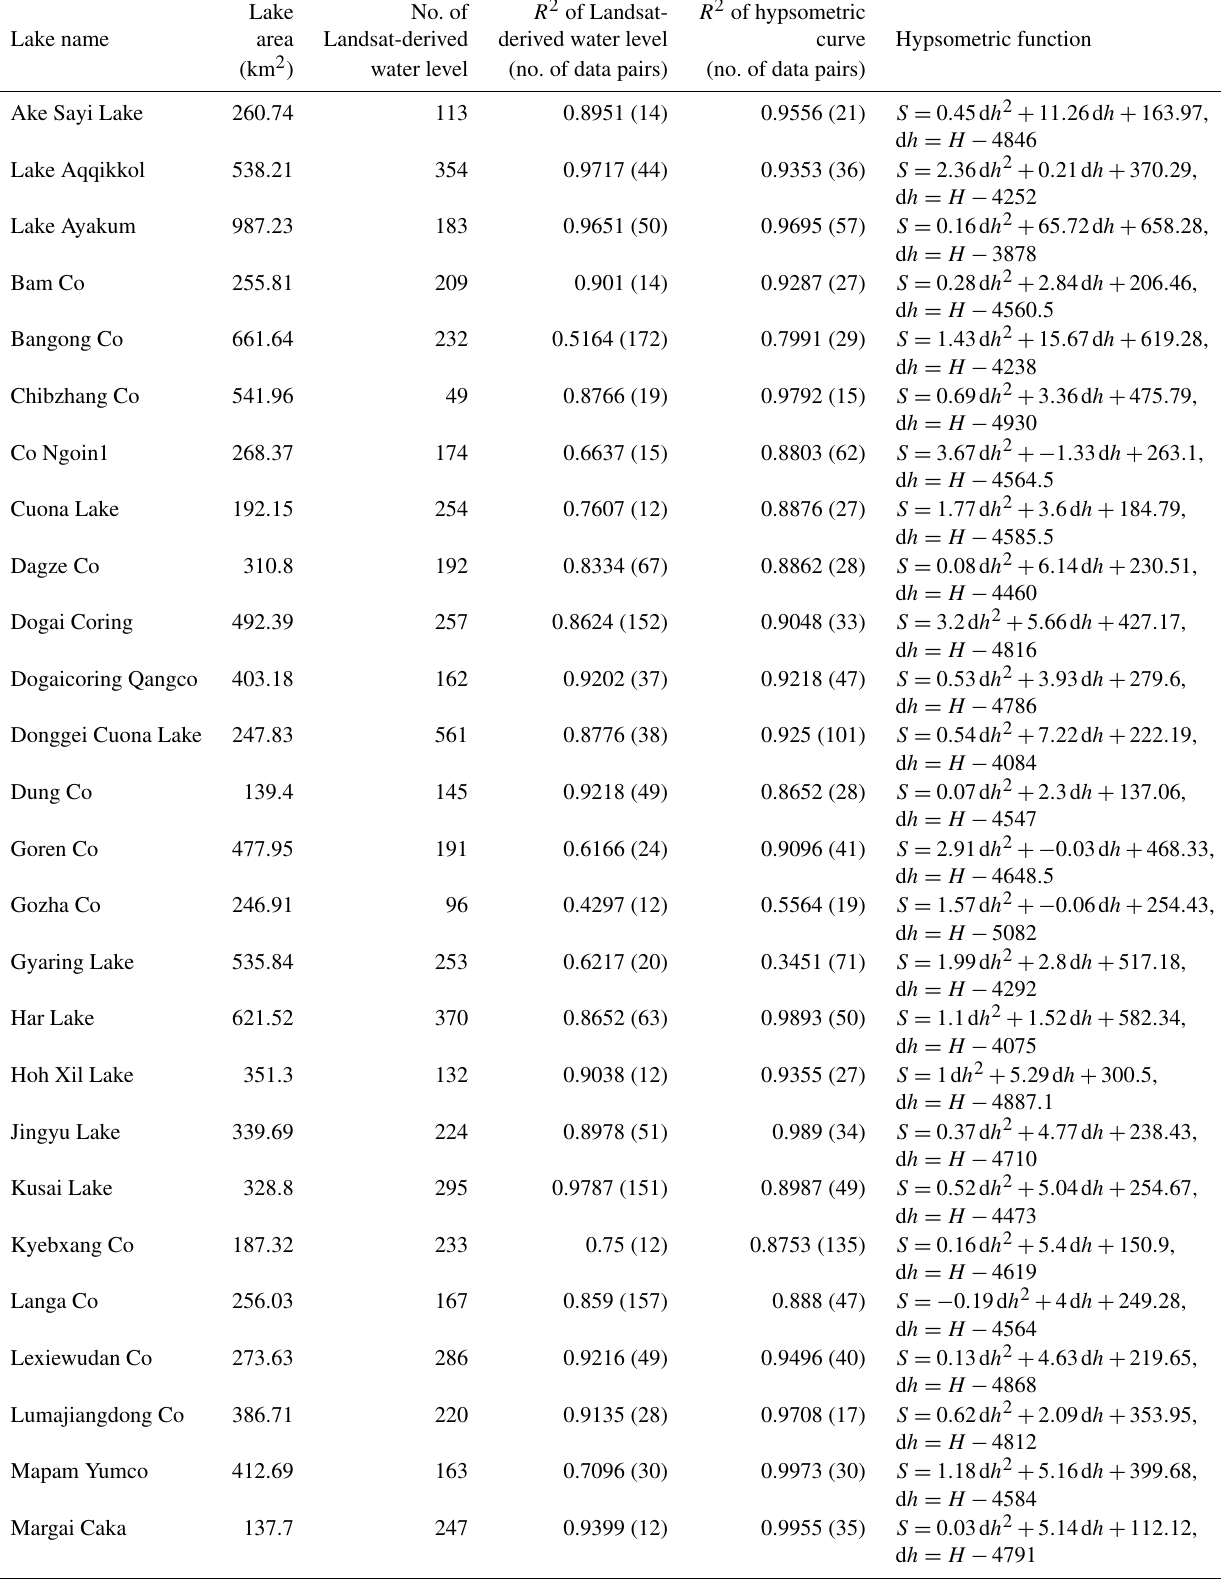
Table 3. Summary of regression analyses and hypsometric function by lake. Lake No. of R 2 of Landsat- R 2 of hypsometric Lake name area Landsat-derived derived water level curve Hypsometric function (km 2 ) water level (no. of data pairs) (no. of data pairs)